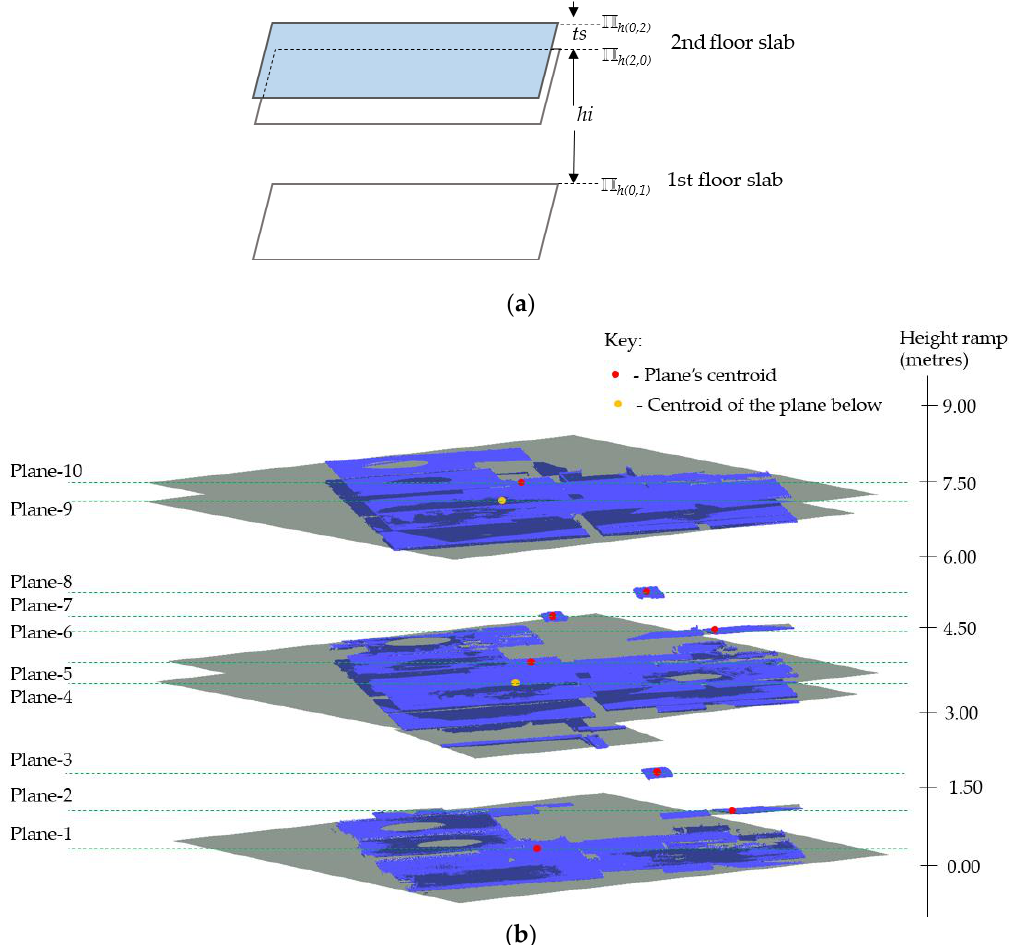
Figure 10. Vertical alignment of horizontal planes defining the respective floors and ceilings: ( a ) Planes representing the first- and second-floor slabs; ( b ) Horizontal patches including the detected occluding objects positioned along the z-axis.